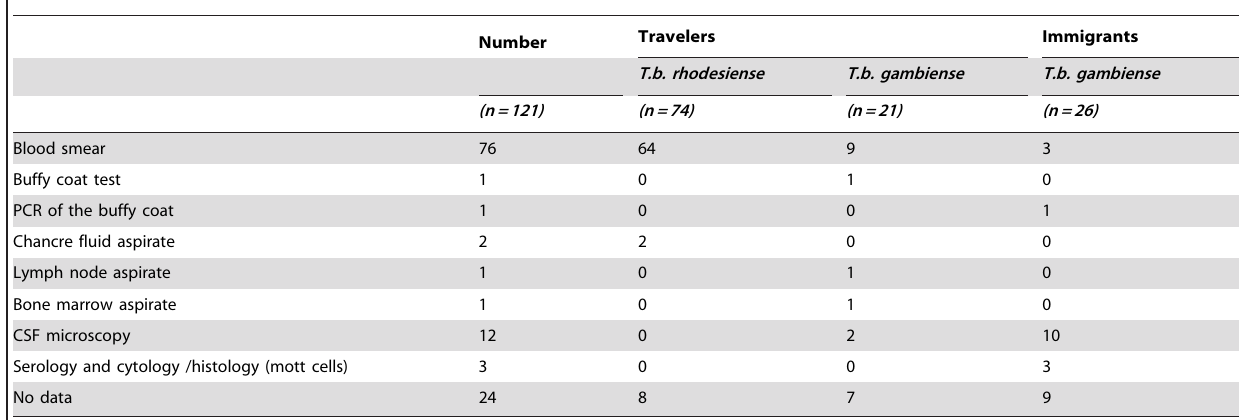
Table 5. Diagnostic